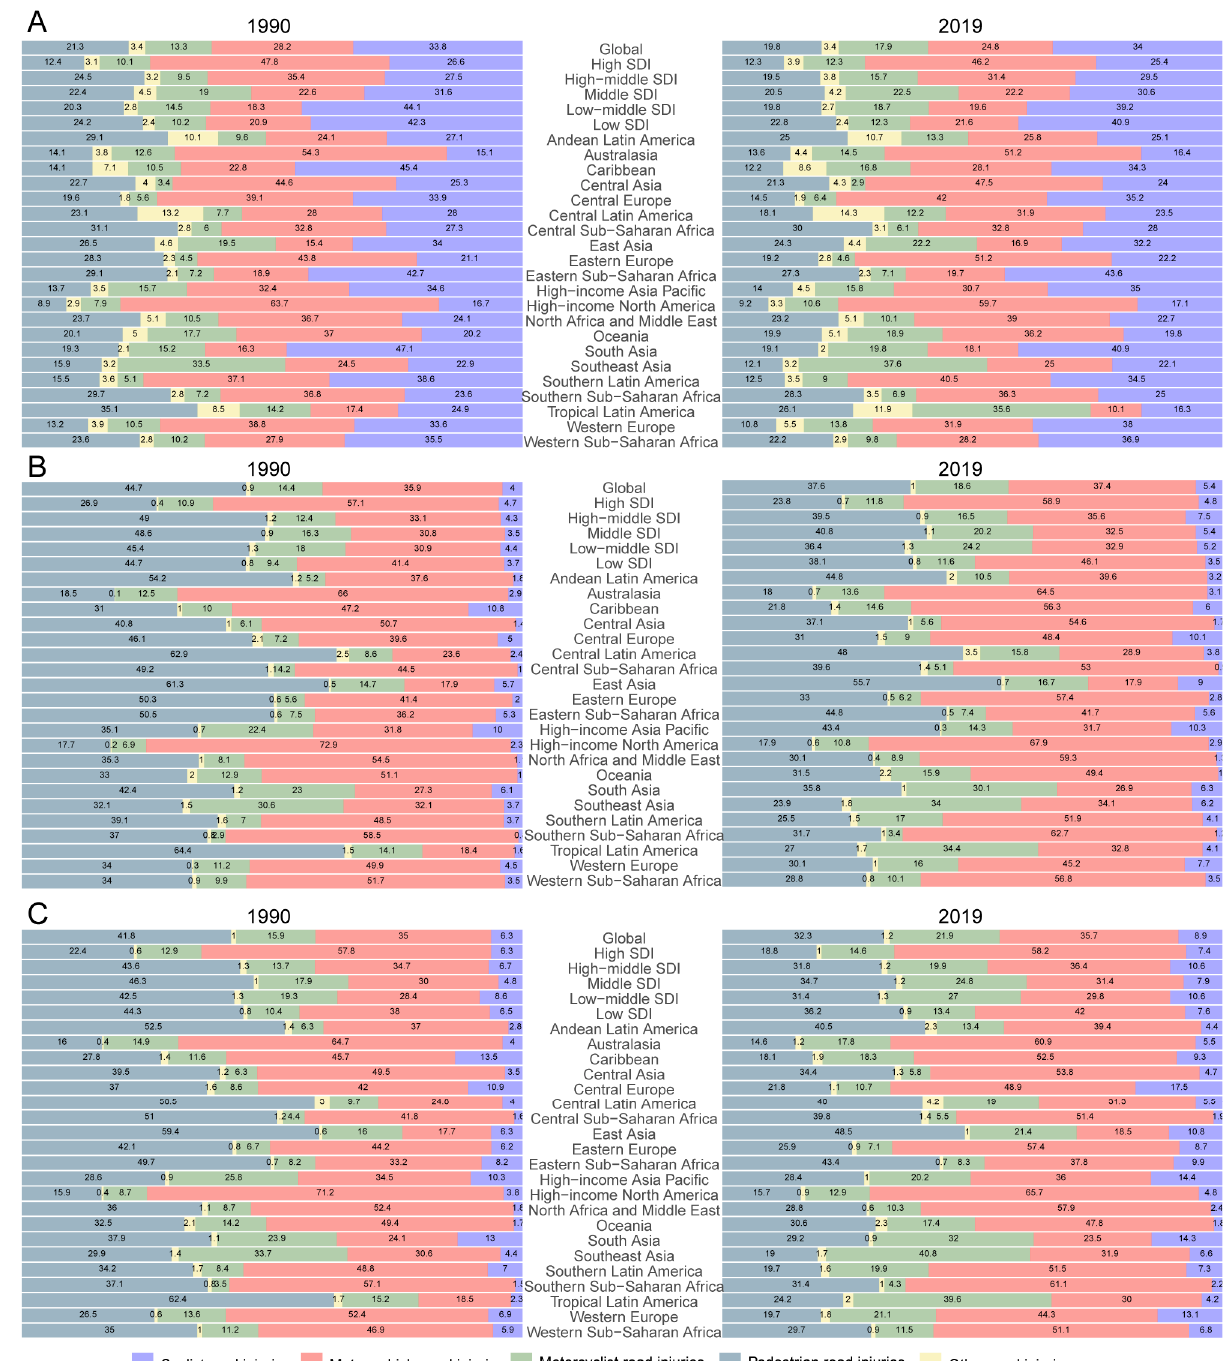
Figure 5. RIs subtypes in the different SDI regions and GBD regions. They are presented by incidence ( A ), deaths ( B ), and DALYs ( C ) for 1990 and 2019.